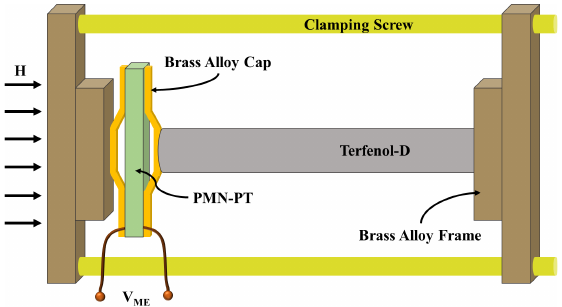
Figure 11. Sketch of the magnetoelectric structure based on Terfenol-D and a PMN-PT cymbal-like transducer proposed in